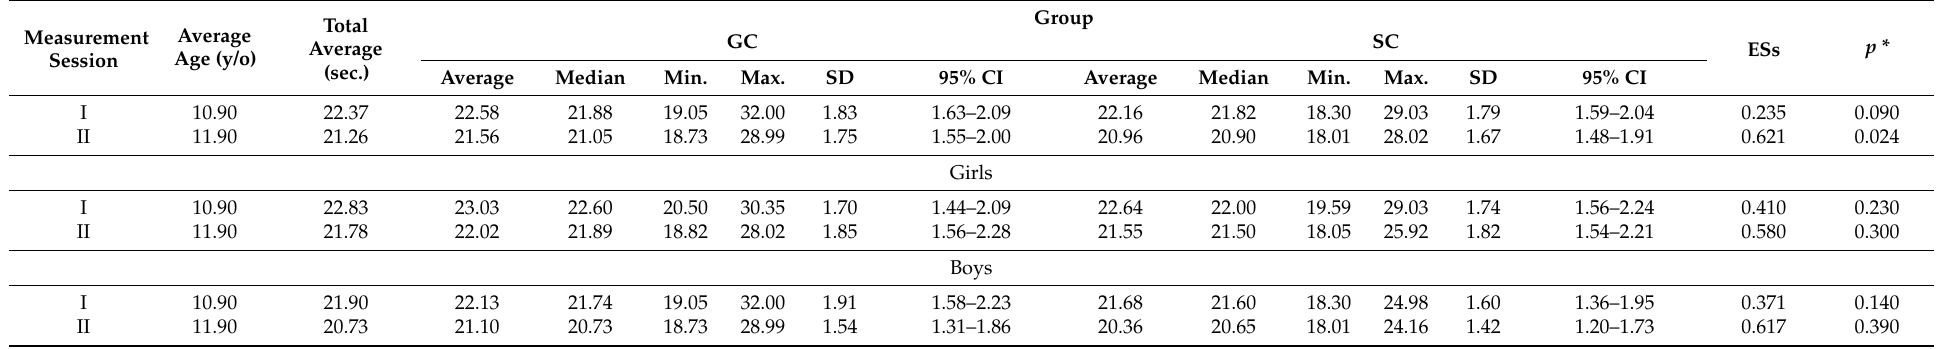
Table 3. Results of the shuttle run test, sec.